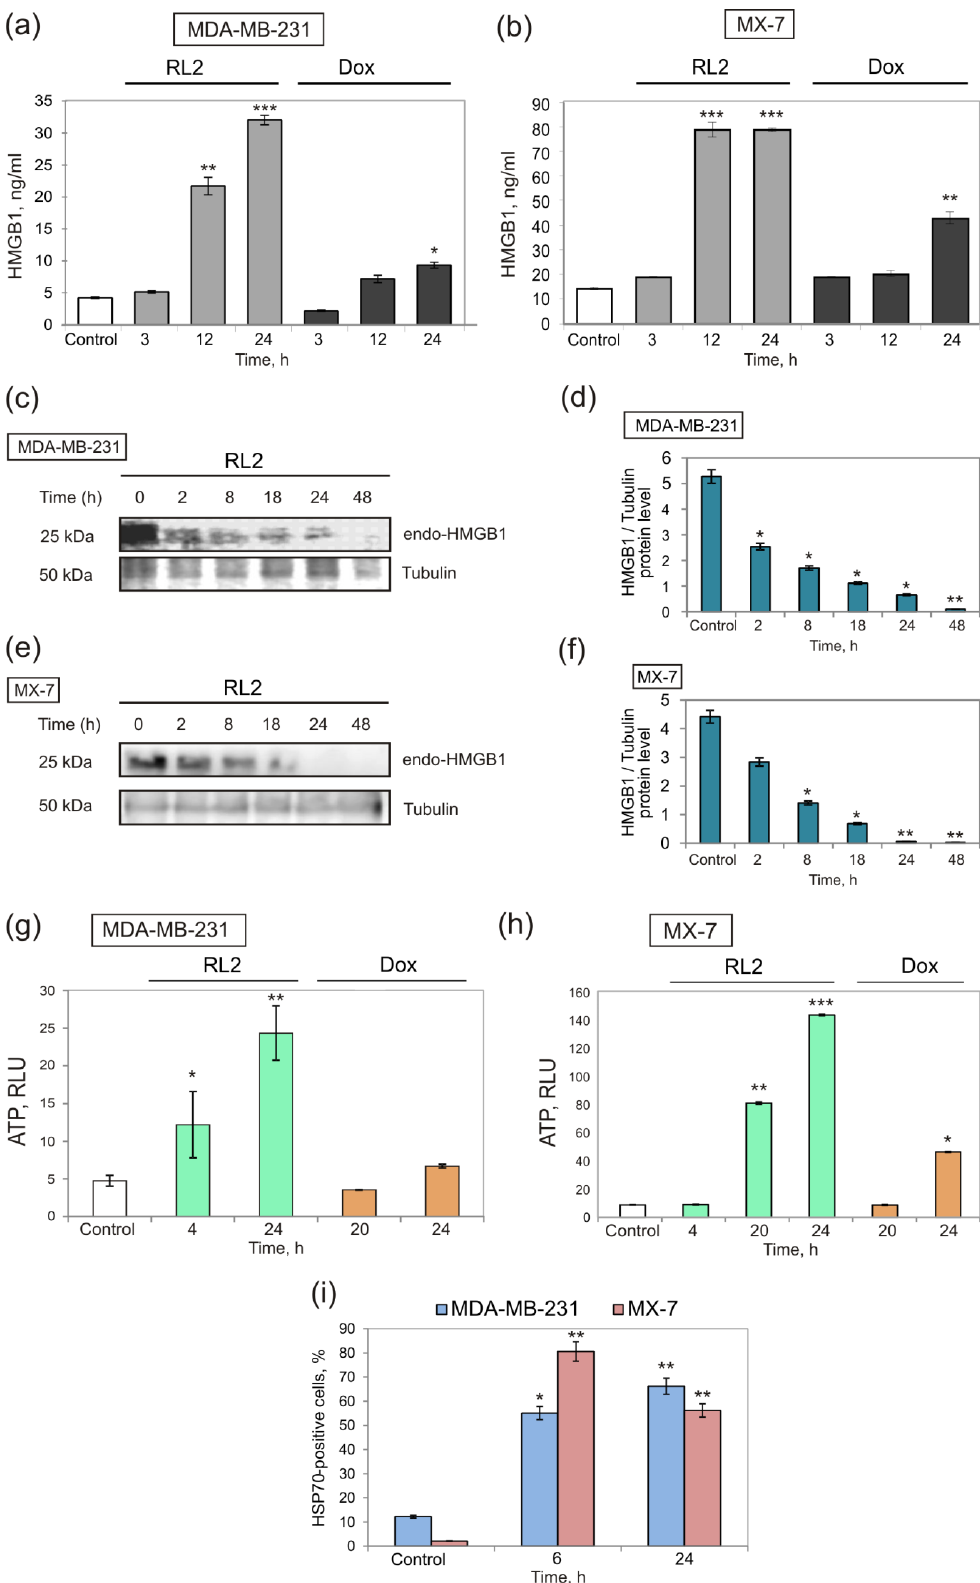
Figure 2. RL2 induces HMGB1 and ATP release and HSP70 translocation in treated cells. MX-7 and MDA-MB-231 cells were treated with RL2 (0.3 mg / mL) or Doxorubicin (0.1 µ g / mL) for 2–48 h. ( a , b ) Extracellular HMGB1 in RL2- and Dox-treated cells; ( c – f ) Cellular HMGB1 in RL2-treated